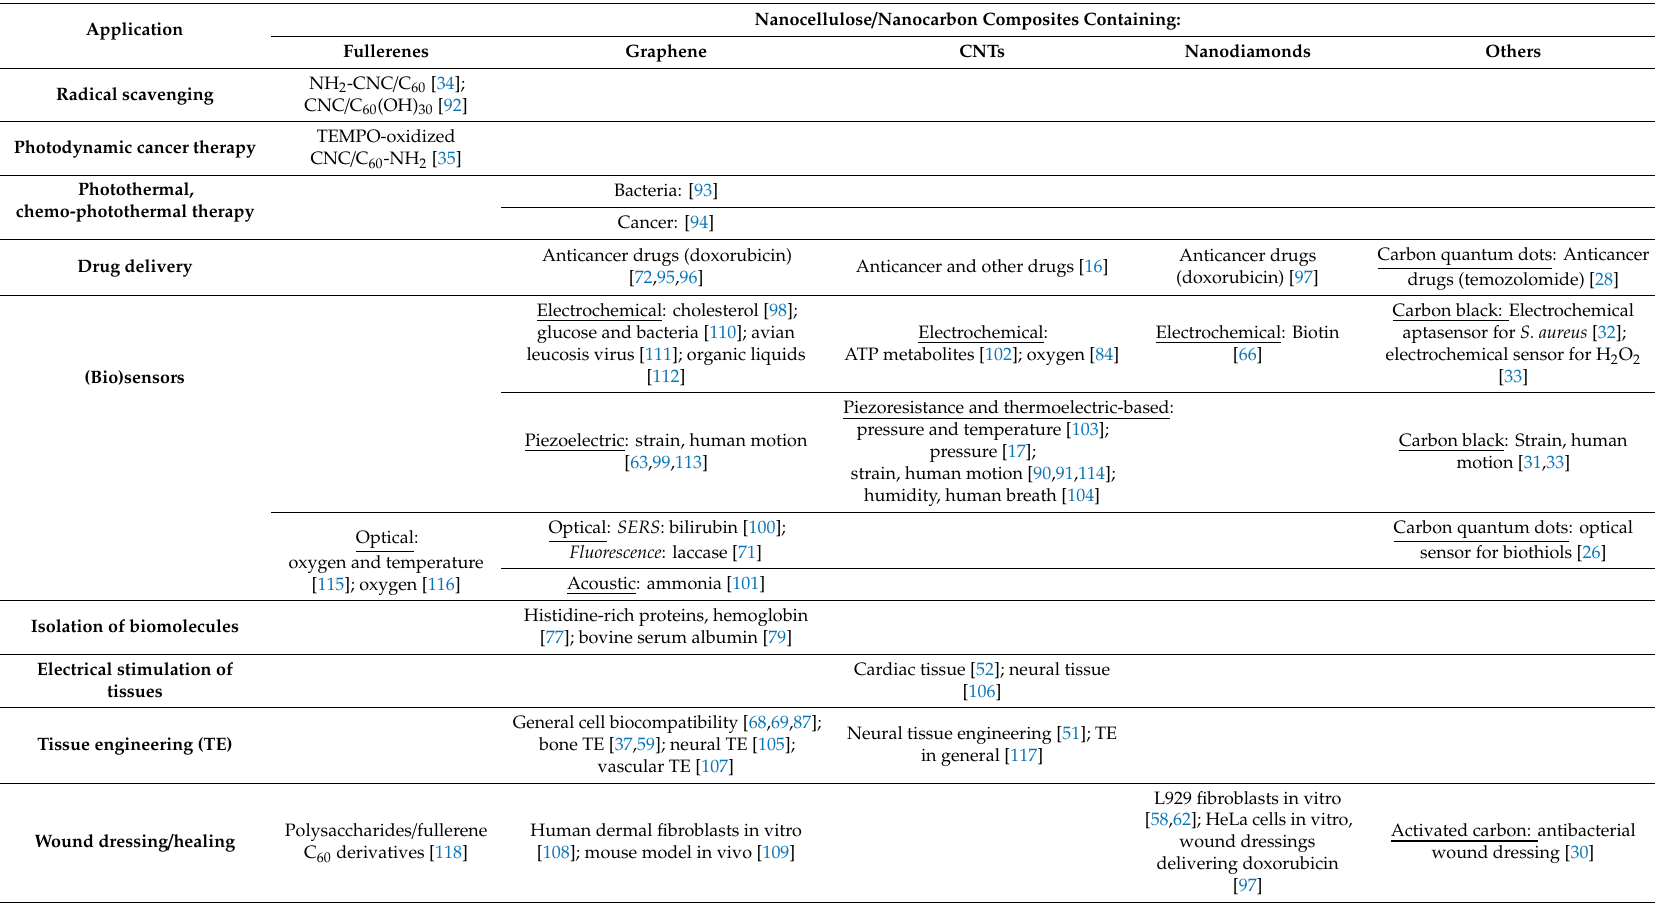
Table 1. Biomedical applications of nanocellulose / nanocarbon